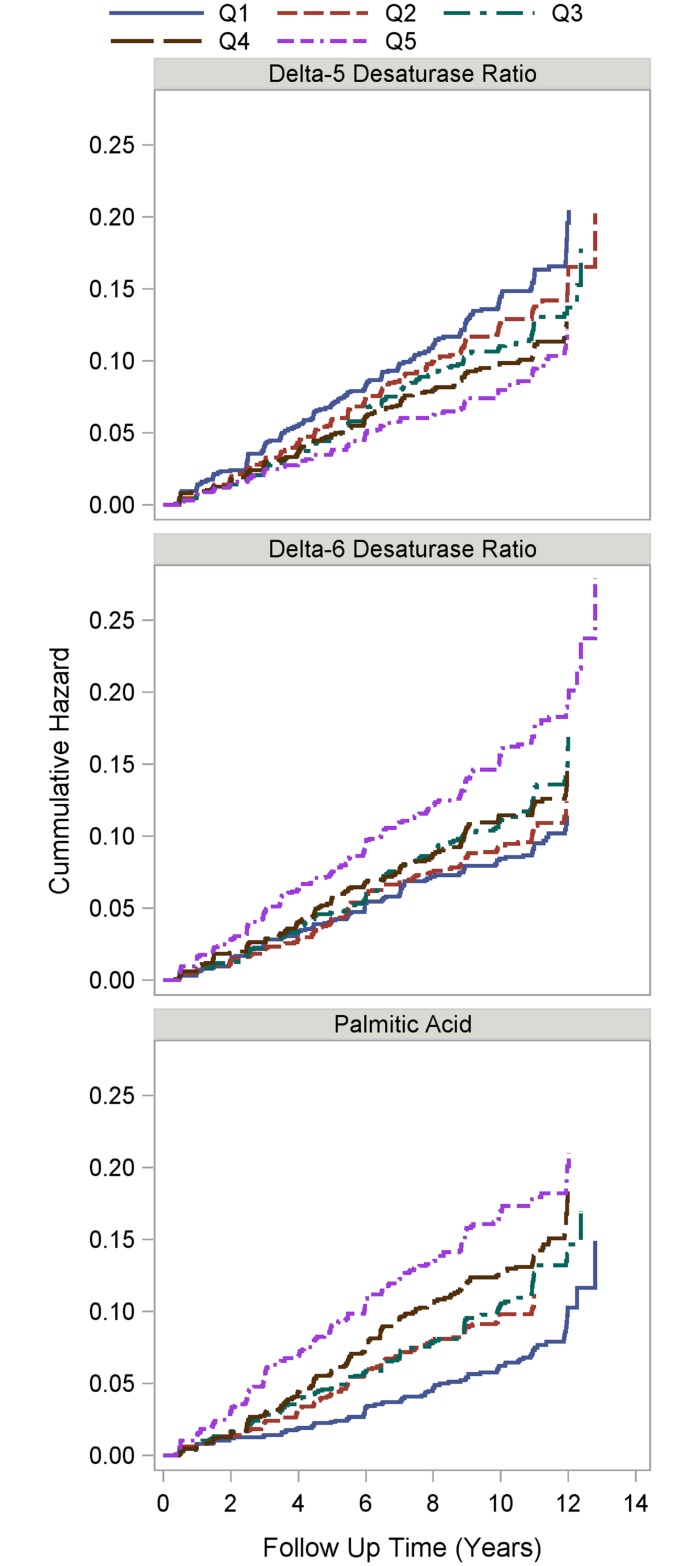
Cumulative Nelson-Aalen hazard estimates of incident diabetes by baseline delta-5 desaturase ratio (top), delta-6 desaturase ratio (middle) and palmitic acid level (bottom).Log Rank p-values = 0.0007, <0.0001 and <0.0001, respectively.